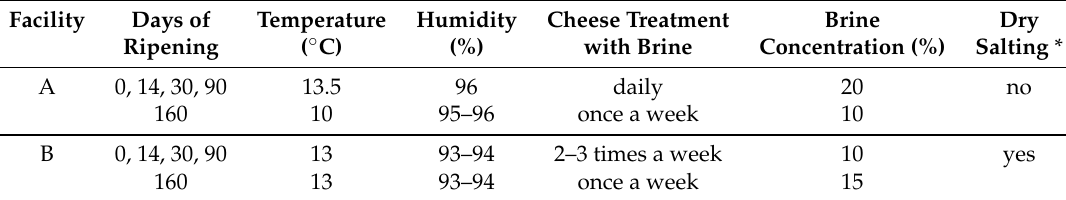
Table 1. Ripening conditions according to the different VB producing facilities and the different time points investigated in this